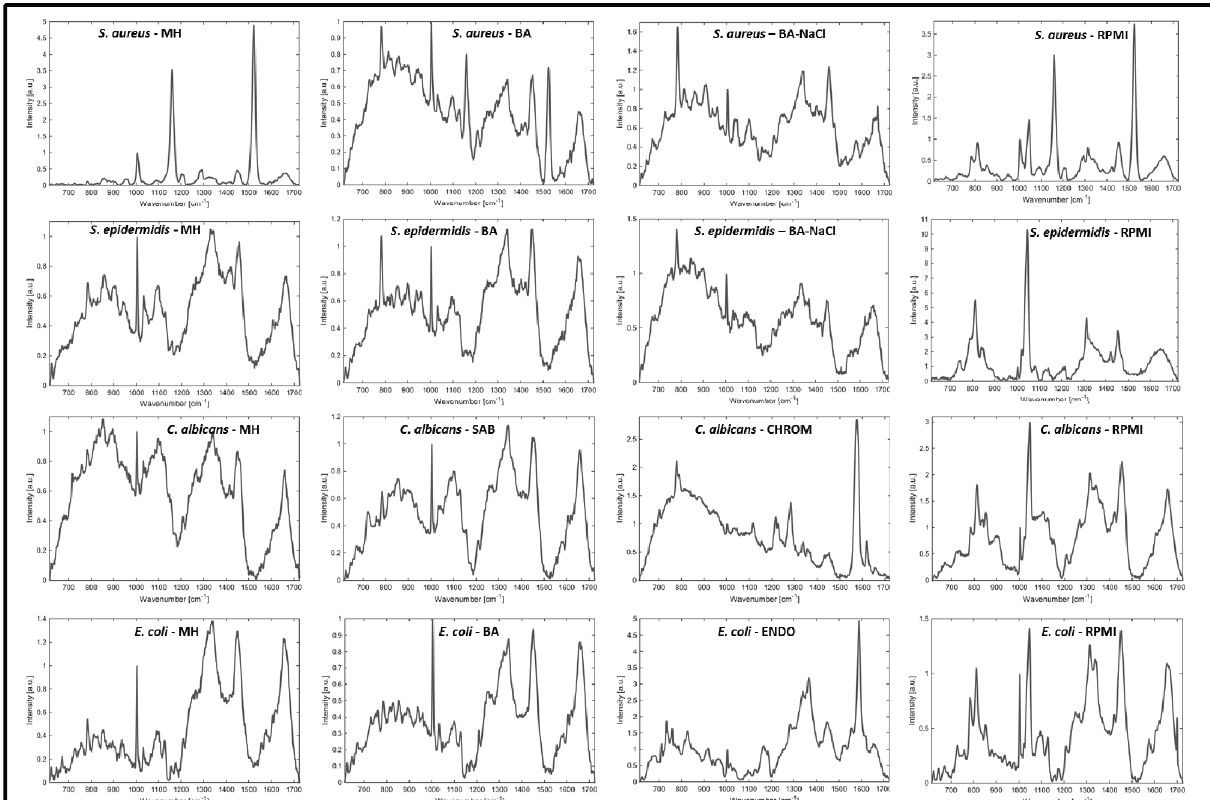
Figure 4. Normalized representative Raman spectra of the microorganisms on all used culture media (ENDO—Endo agar, BA—blood agar; BA-NaCl—blood agar with 10%